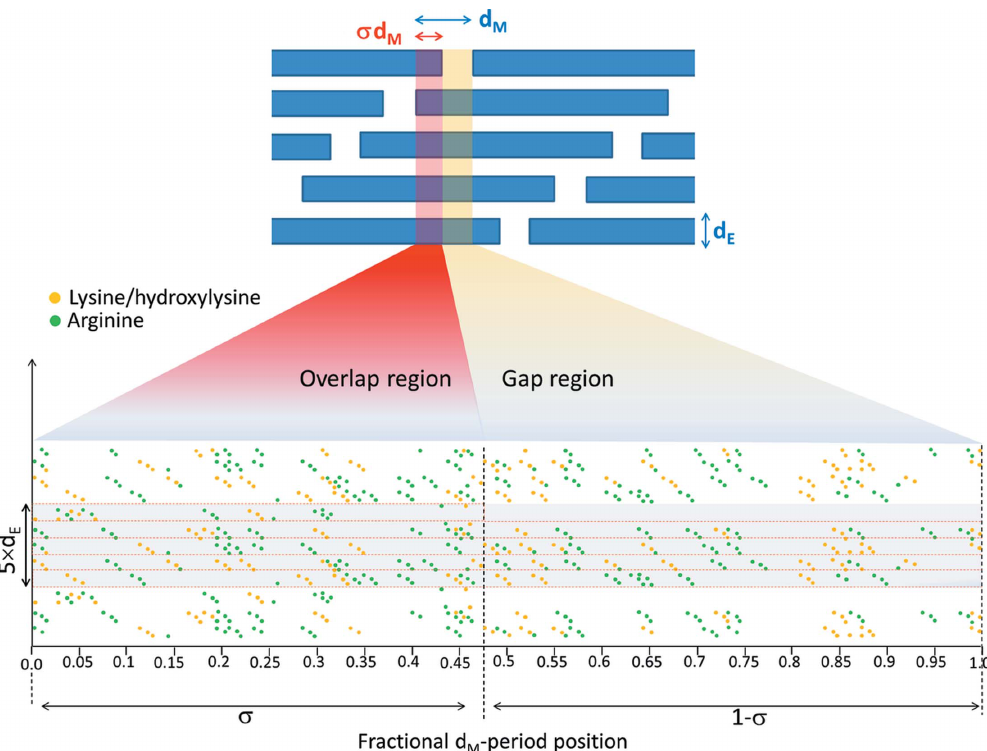
Figure 4 Top: schematic (not to scale) of the collagen staggered structure. Bottom: linearized projection of the 3D triple-helix collagen residues, with the lysine/ hydroxylysine (orange bullets) and arginine (green bullets) amino acid positions shown as a function of the fractional d M -period coordinate. glycation as a function of the fractional d -period coordinate, M we assume that the glycation is proportional to the product of ( x , y ) (cid:5) D ( x , y ), see the distributions of the amino acids, D arg lys Fig. 6, where x and y are the horizontal (fiber axis) and vertical (lateral direction) coordinates, respectively. This product